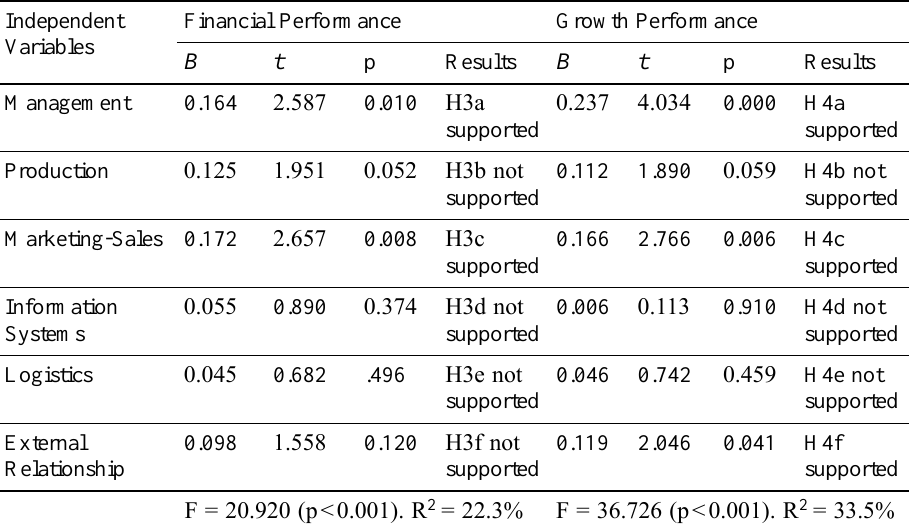
Table 6. The regression results among BCs and business